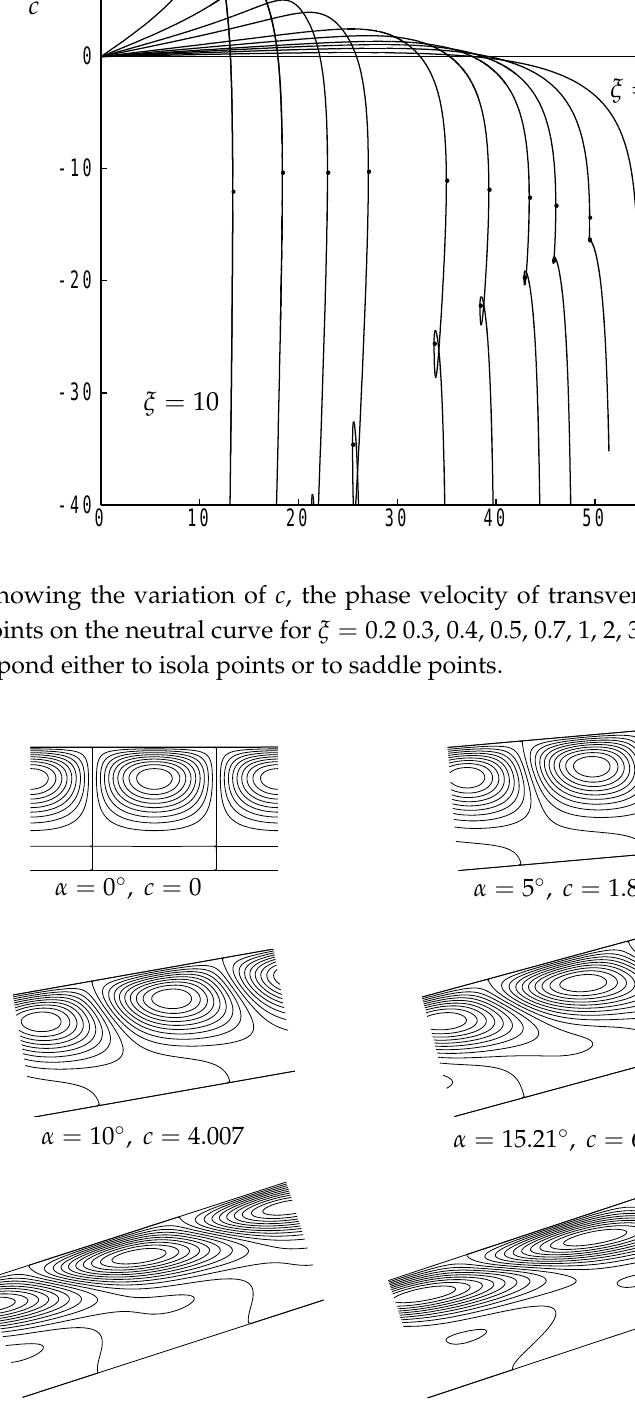
Figure 6. Showing the disturbance isotherms for one spatial period for transverse rolls when ξ = 5. The isotherms are at 20 equally-spaced intervals in each case.